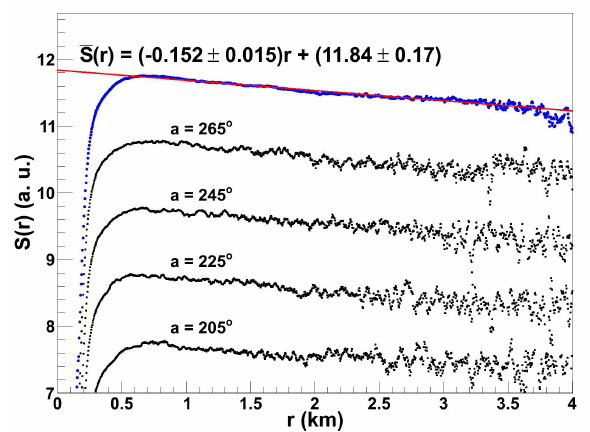
Fig. 2. Averaged S -function for different horizontal di- rections over the PPI scan performed at 11:54CET on 25 May 2010, with apparent nonlinear data excluded. The line ¯ S(r) =( − 0.152 ± 0.015) r +(11.84 ± 0.17) is a result of least squares linear fit in the range between 0.8 and 3.5km, yielding a correlation coefficient of 0.94. The resulting horizontal atmospheric extinction coefficient α is 0.076km − 1 , with relative error of about 0.1 due to atmospheric inhomogeneity. S -functions with azimuthal angles of 265 ◦ , 245 ◦ , 225 ◦ , and 205 ◦ are also shown with an incremental shift minus one from the averaged